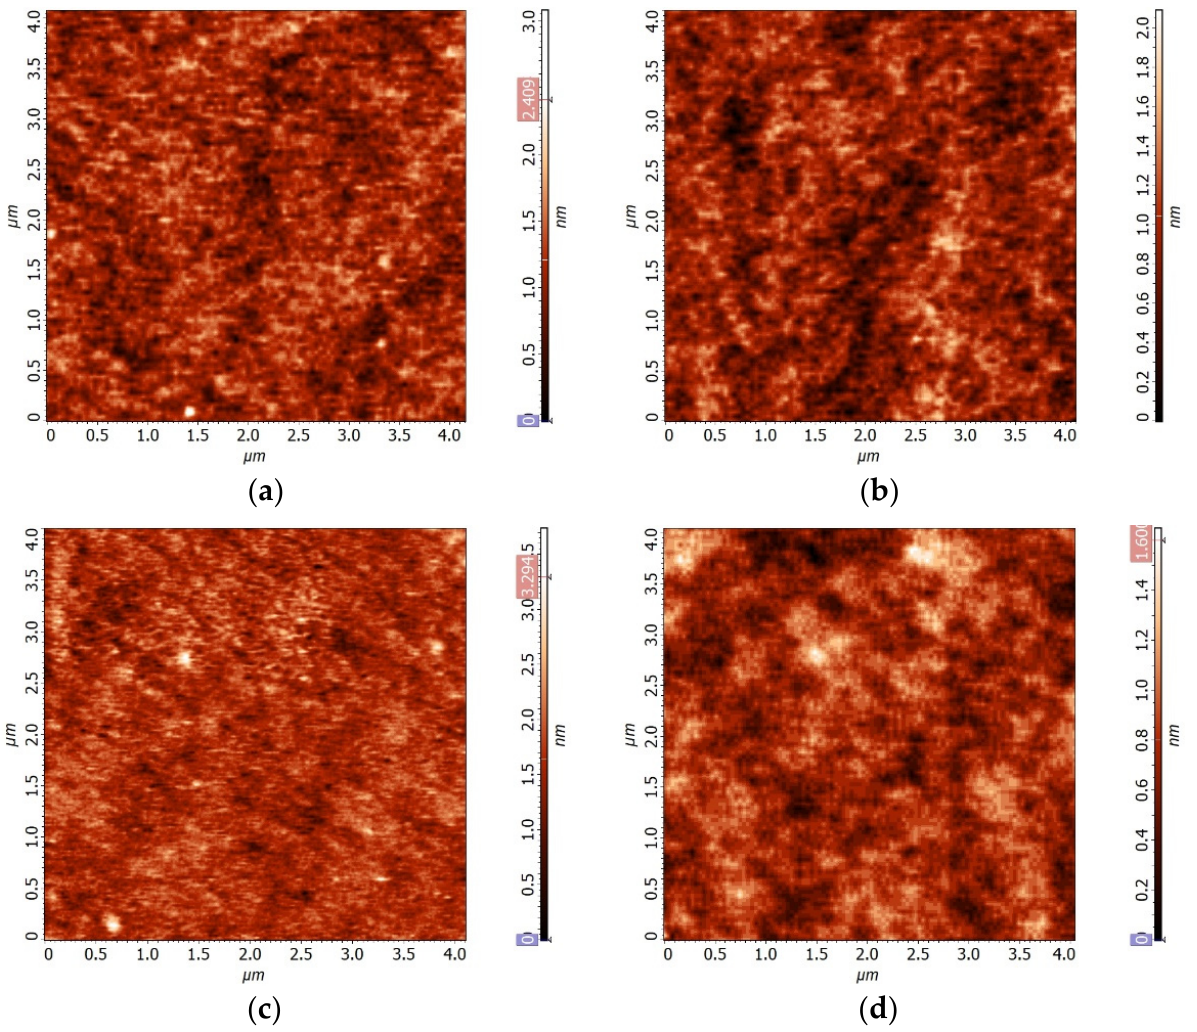
Figure 4. AFM topography images scan size 4 × 4 μ m of the Ir(III)-complex doped in: ( a ) CBP; ( b ) mCP; ( c ) TAPC; ( d ) TCTA. Table 1. AFM and SE results for the spin-coated thin films.